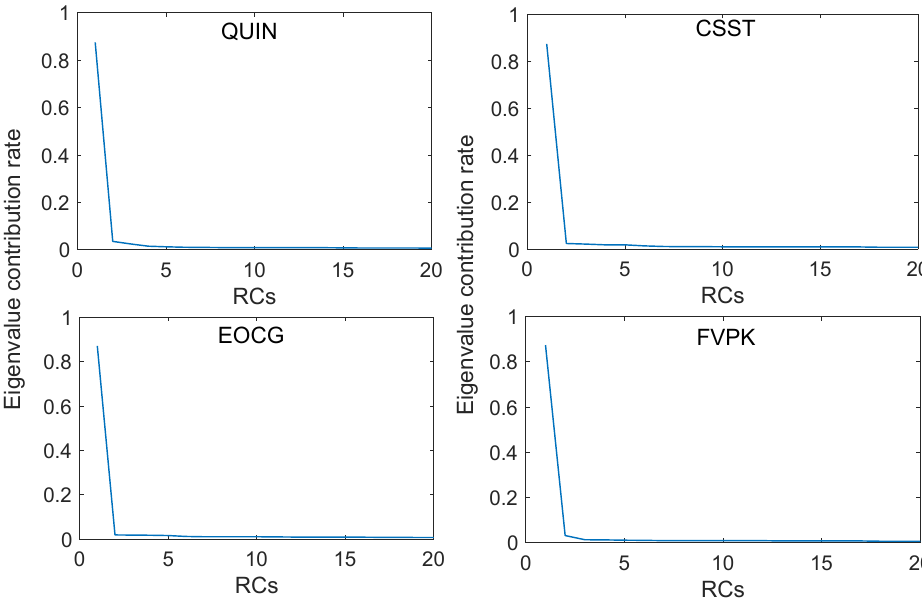
Figure 6. Eigenvalue contribution rate.